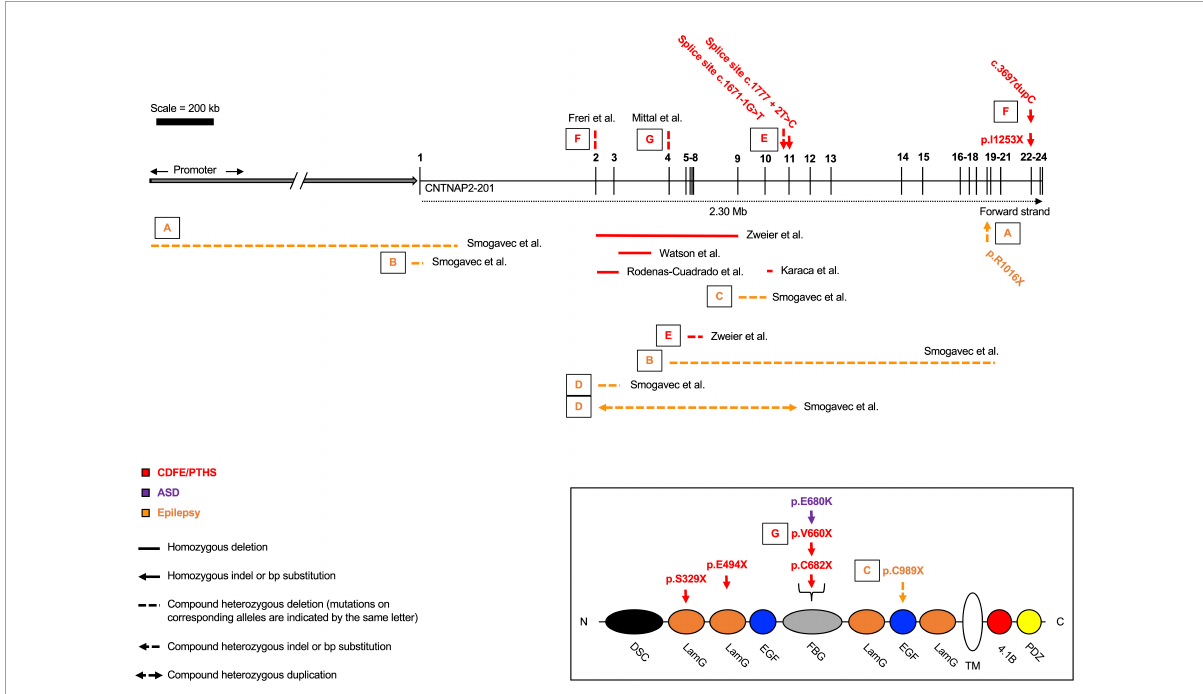
FIGURE2 Homozygous and compound heterozygous contactin-associated protein-like 2 ( CNTNAP2 ) mutations. Mutations affecting the CNTNAP2 locus are shown with their associated disorders. Mutations are commonly found in the middle of the gene, between exons 2 – 13. Cortical dysplasia focal epilepsy/Pitt-Hopkins syndrome (CDFE/PTHS) are the most common diagnoses, though patients typically fall into multiple categories. Mutations that map to a subdomain of the contactin-associated protein-like 2 (CASPR2) protein are shown separately. Diagram not perfectly to scale. Works cited are listed in Supplementary Material 1 . ASD, autism spectrum